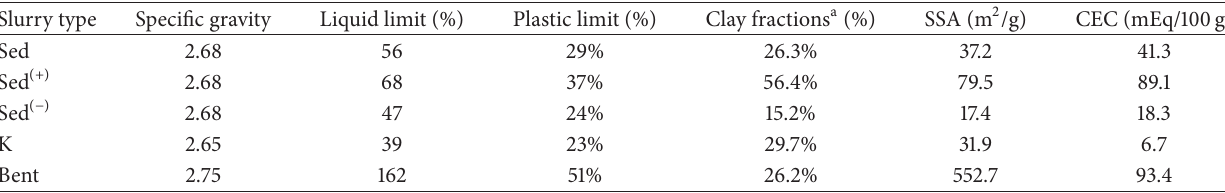
Table 1: Physical properties of slurries.